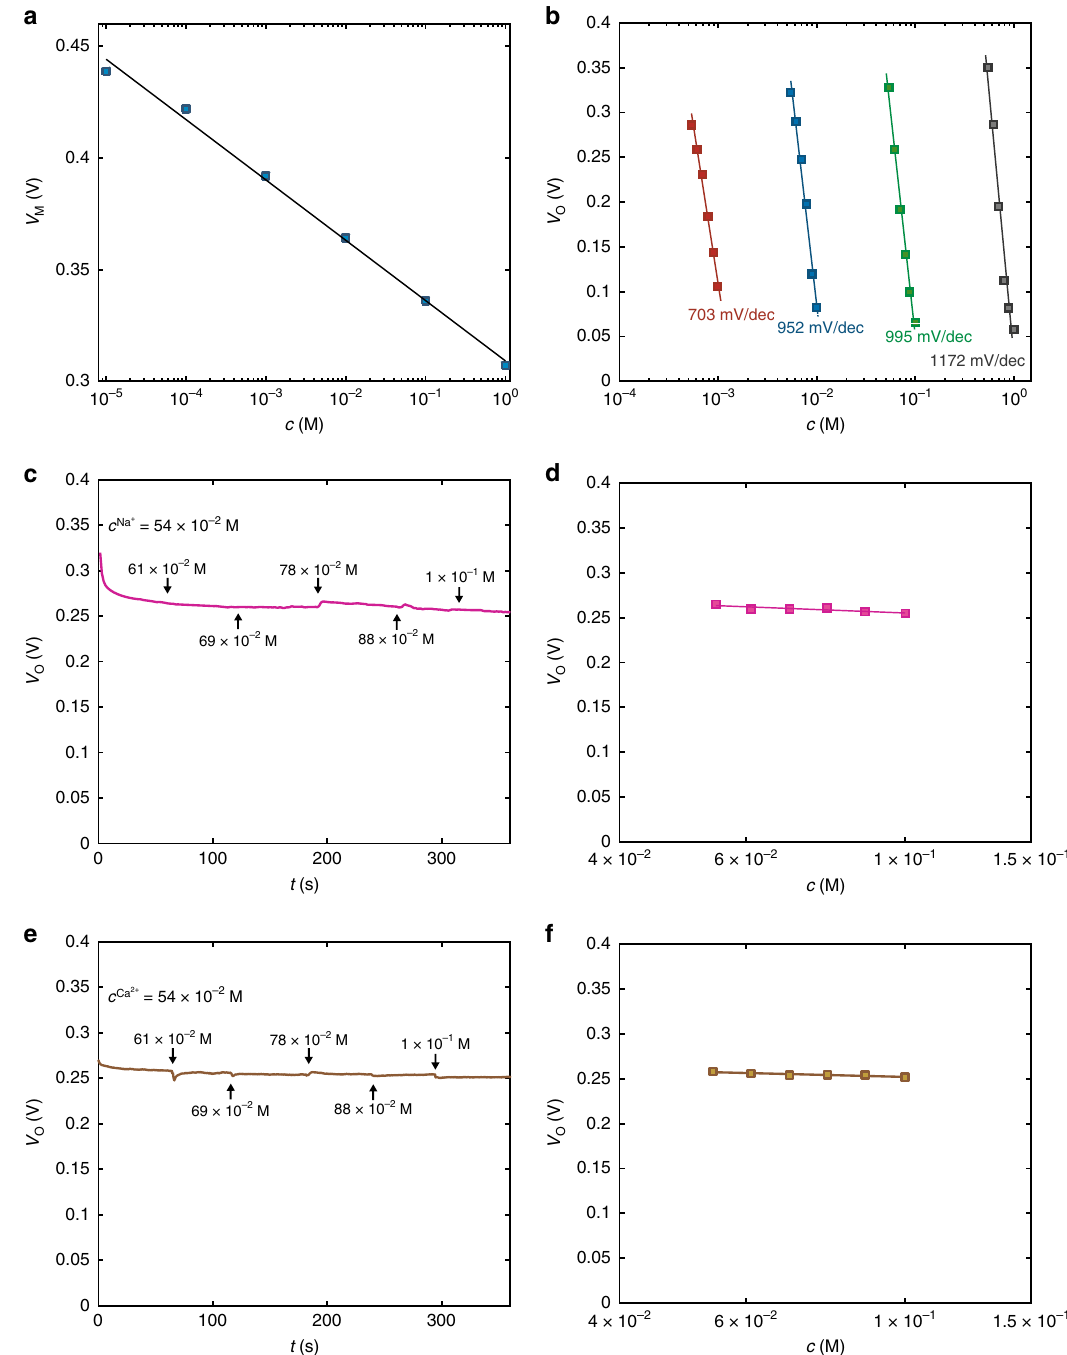
Fig. 6 Selective ion detection and real time monitoring. a Measured (symbols) V M as a function of the potassium concentration for the potassium selective organic electrochemical transistor complementary ampli fi er. The full line is the linear least square fi t to the measurements, and its slope gives a wide-range sensitivity S M = 28 mV dec − 1 . b Measured (symbols) V O – c K + high sensitivity characteristics comprising the whole physiological range. Solid lines are the linear least square fi t to the measurements, yielding S A = 703 mV dec − 1 , 952 mV dec − 1 , 995 mV dec − 1 , 1172 mV dec − 1 . c, e Control experiment demonstrating the selectivity of the potassium-selective OECT complementary ampli fi er. V O is measured over time and the Na + ( c ) or Ca 2 + ( e ) concentration is systematically increased every 60 s from 5.4 10 − 2 M to 1 10 − 1 M. In both cases the K + concentration is constant and amounts to 5.4 10 − 2 M. d, f Measured (symbols) steady state V O as a function of c Na + ( d ) or c Ca2 + ( f ). Solid line is the linear least square fi t to the measurements and yields a cross-sensitivity S CR,Na + = 33 mV dec − 1 for Na + , and S CR,Ca2 + = 20 mV dec − 1 for Ca 2 + , con fi rming the excellent selectivity of the output